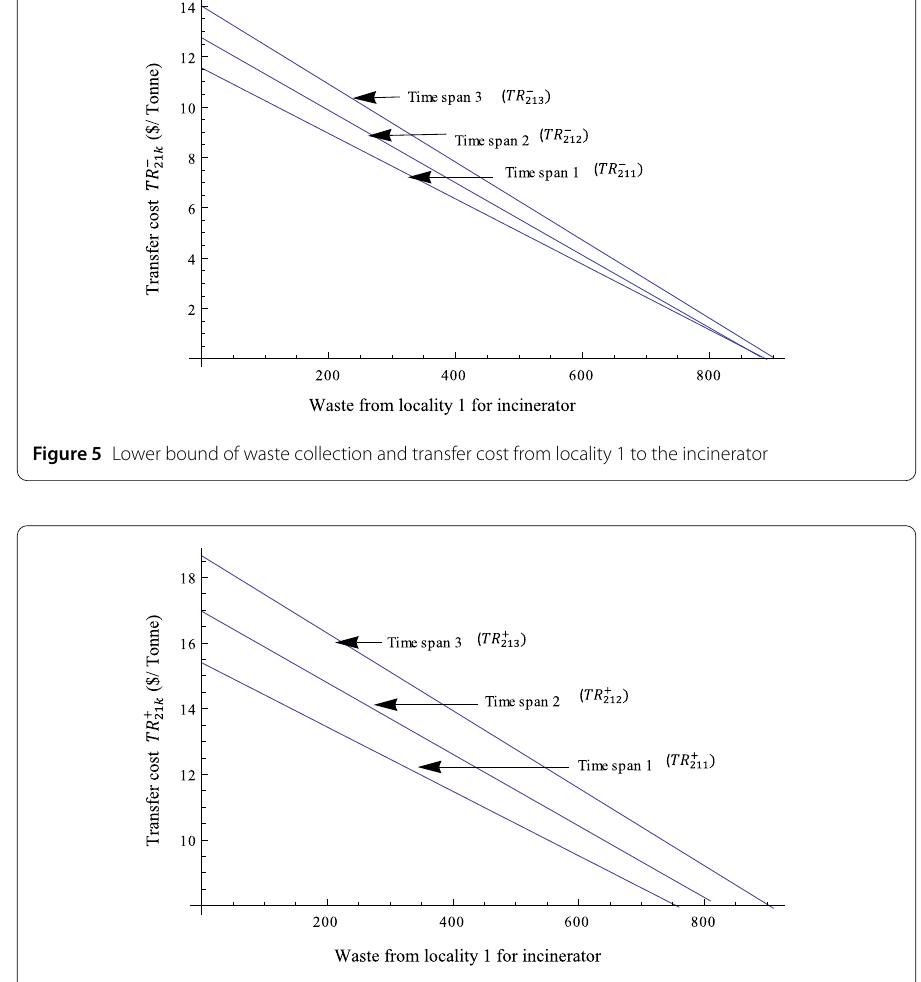
+ [–0.0209,–0.0158] x 2